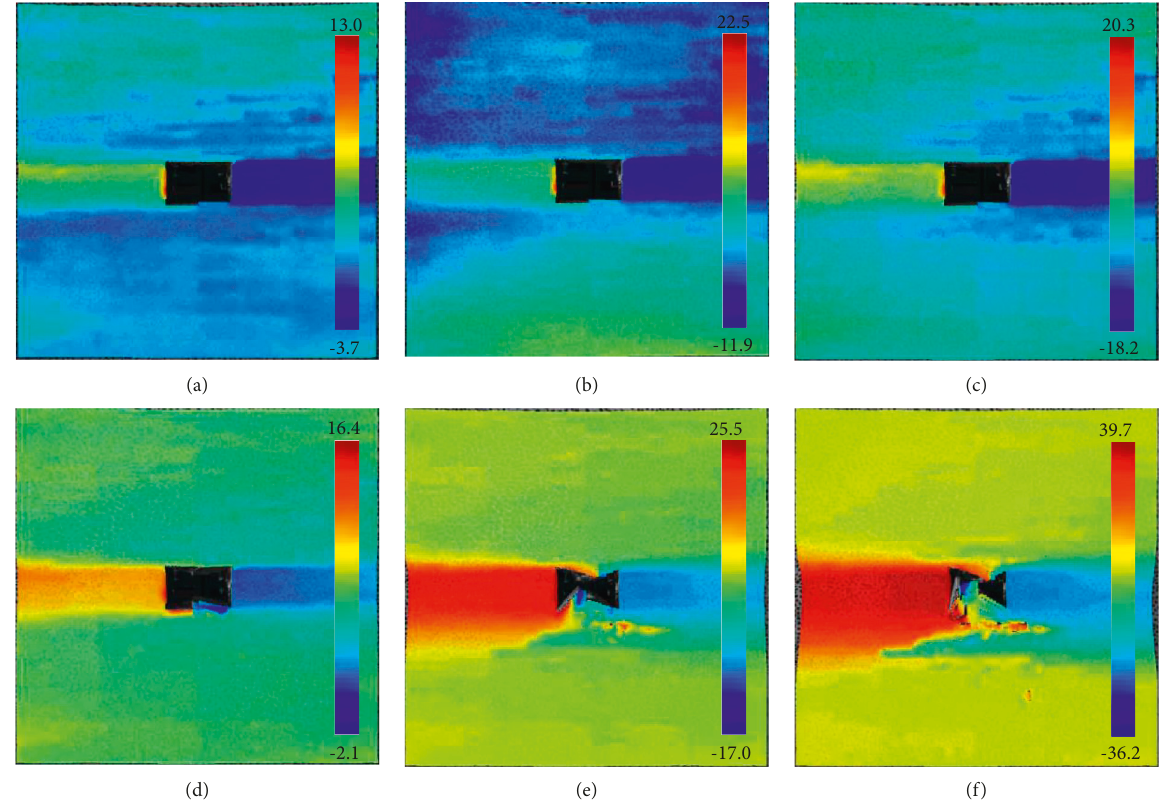
Figure 6: Evolution of horizontal displacement field under different loads; (a) Under load level 4; (b) Under load level 14; and (c–e) Under load level 23 and cumulative duration is 541mins, 542mins, 543mins and 544 mins, respectively. (unit: Figure 12. In the failure stage, the horizontal compressive strain at the monitoring points R01 and R02 increases and